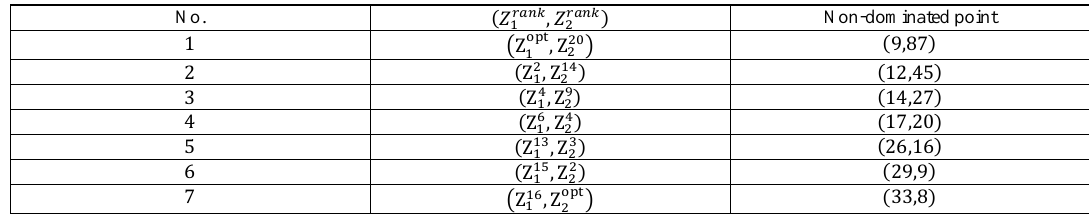
Table 7. All non-dominated points for Example